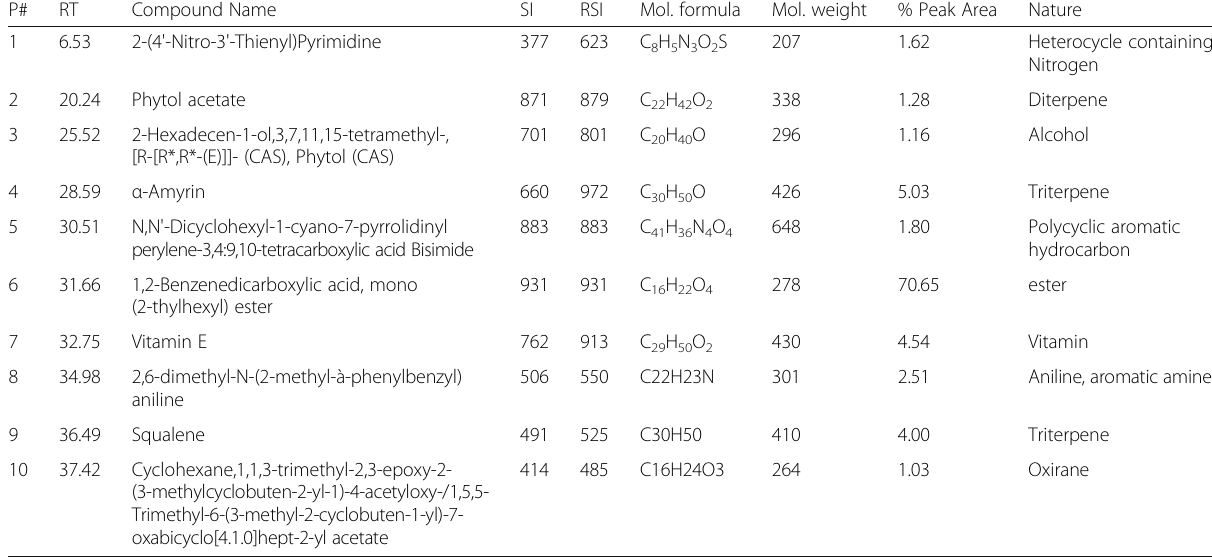
Table 1 Chemical composition of A. hydaspica AHM extract analyzed by GCMS P Peak, RT Retension time, SI Search index, RSI Reverse search index